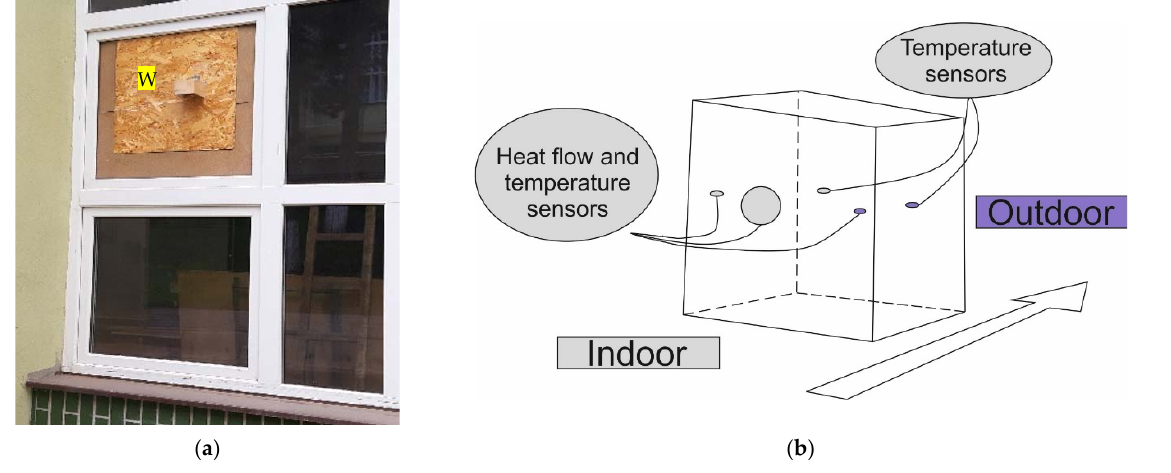
Figure 3. In situ experimental test: ( a ) Positioning of the experimental wall (W); ( b ) Placement of the sensors on the structure.